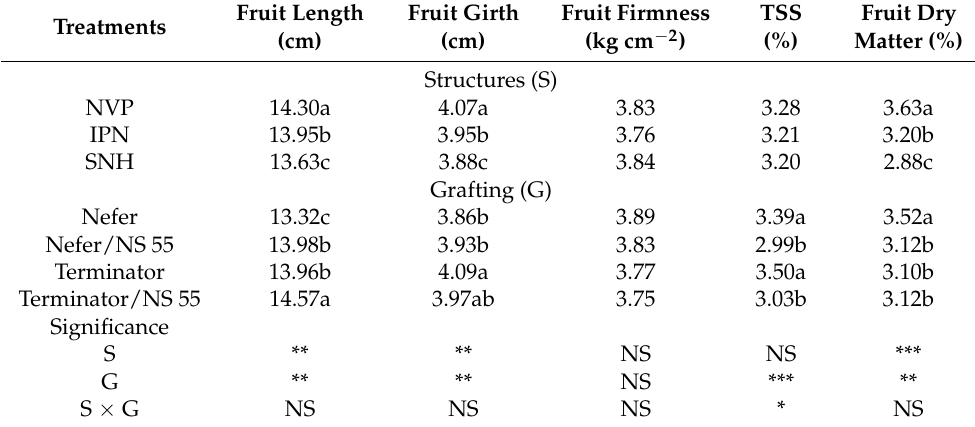
Table 4. Effect of structures and graft combinations on fruit quality